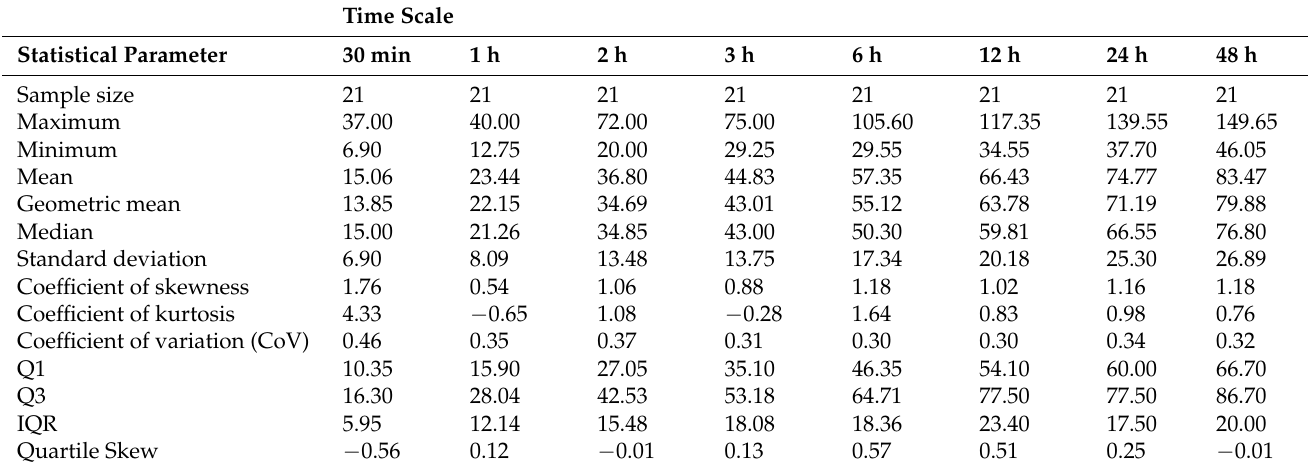
Table 2. Sample statistics of rainfall depth (mm) for several time